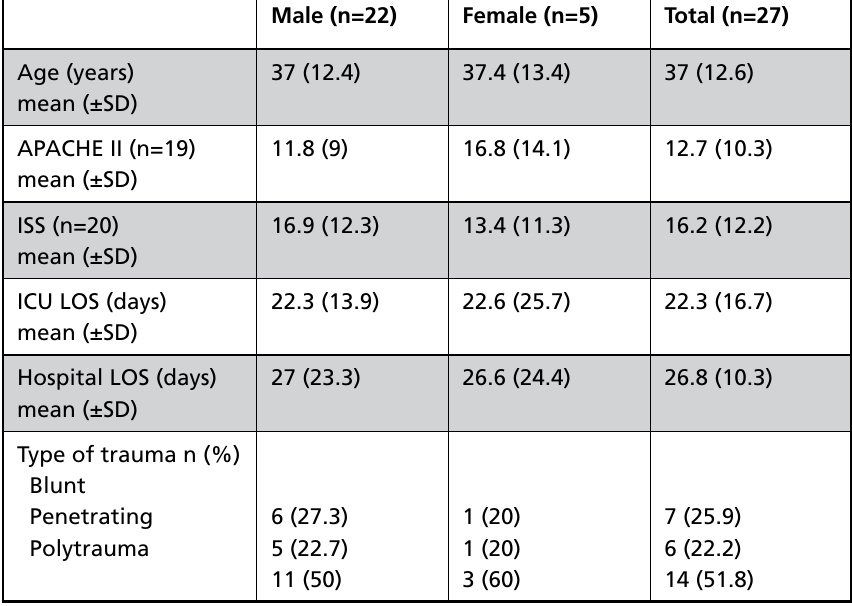
table i: Demographic characteristics of subjects at six months following discharge